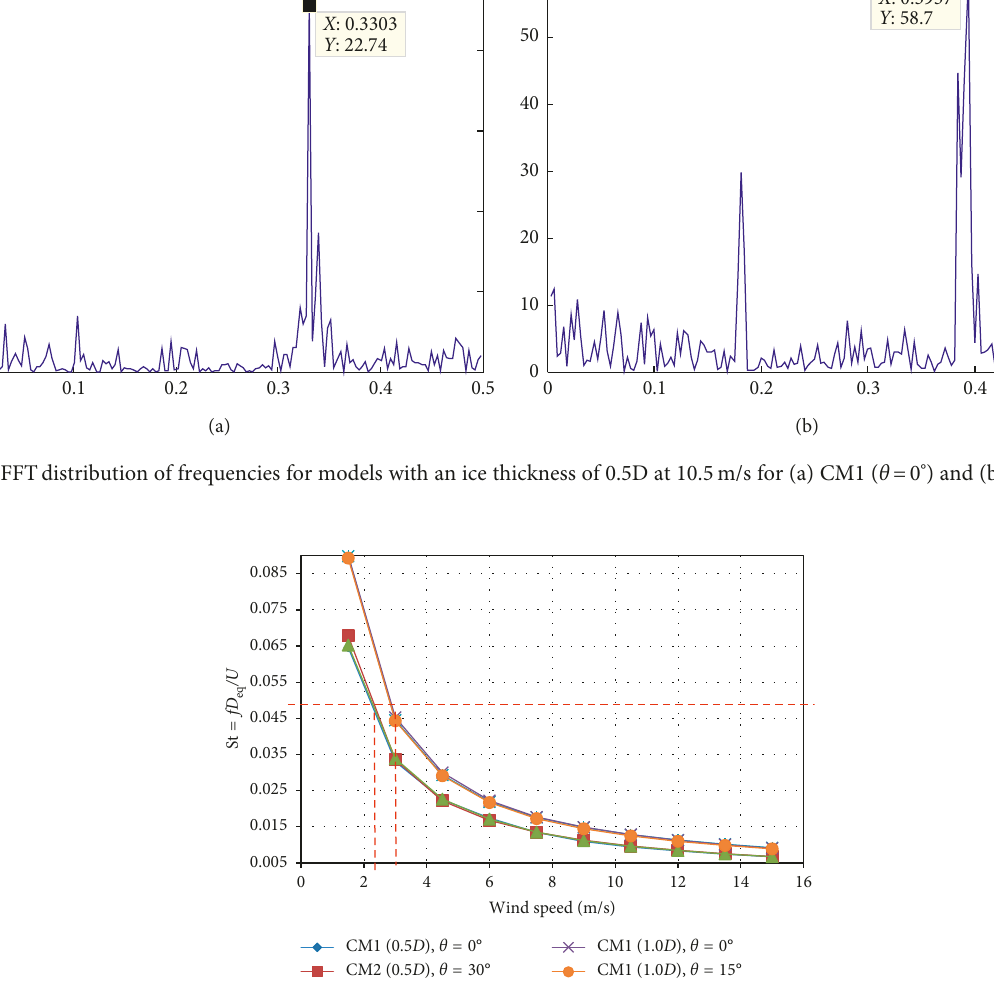
eq /U ) for the vertical